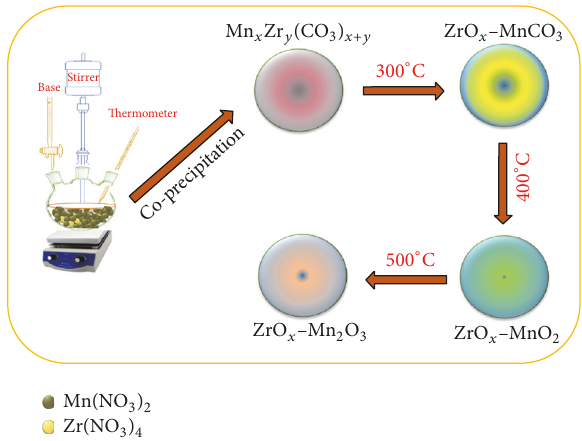
Scheme 1: Graphical representation of the preparation of ZrO carbonate and